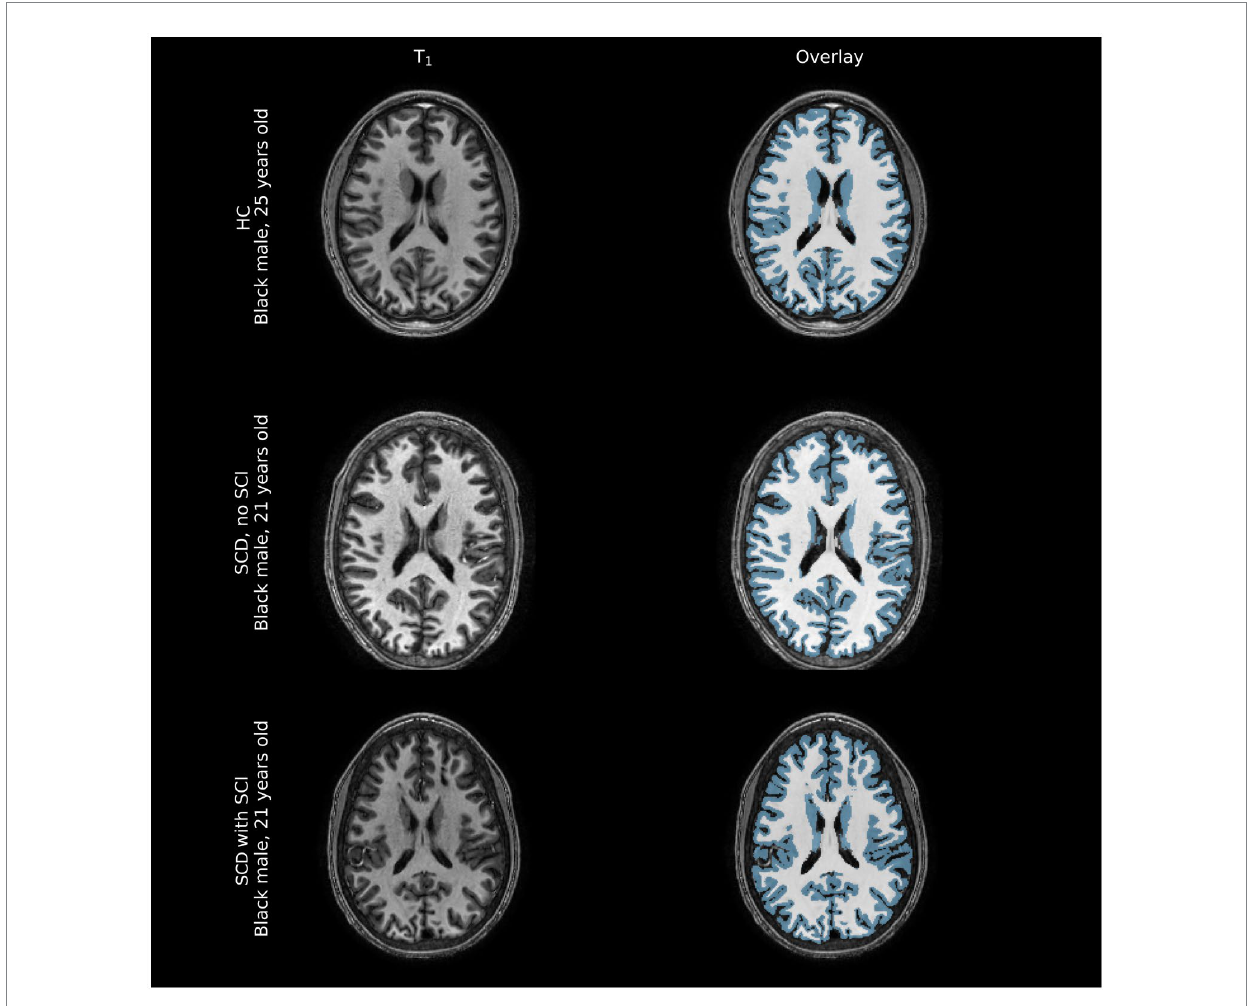
FIGURE 2 Representative comparison of structural images of participant brains along with FreeSurfer-derived gray and white matter segmentations (blue overlay and white overlay, respectively). Tissue volume differences between healthy controls (HC) and individuals with sickle cell disease (SCD) with and without silent cerebral infarcts (SCI) are often not immediately apparent on structural imaging modalities, barring large overt ischemic strokes that were excluded from this